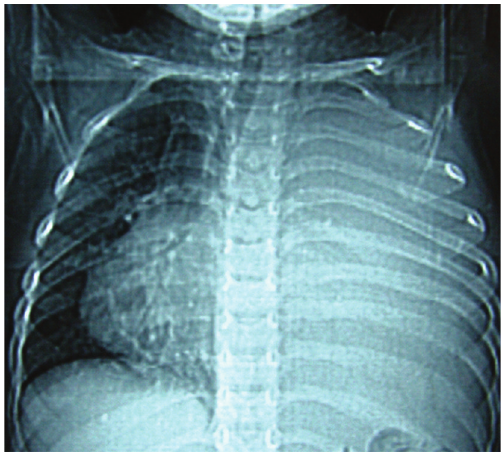
Figure 1: X-ray Chest PA view showing large opacity of entire left hemithorax with mediastinal shift.